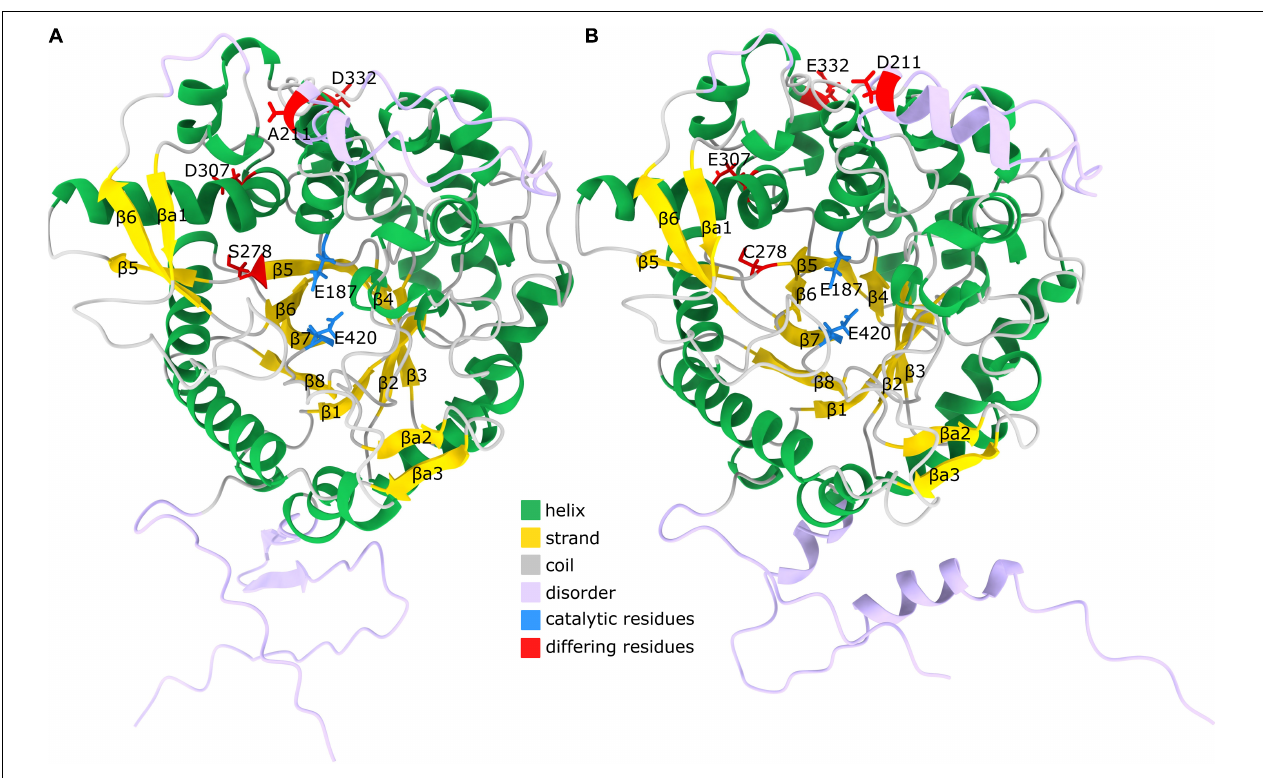
FIGURE 8 | Predicted structure of Ce BGlu. (A) AlphaFold model of Ce BGlu1. Helices are shown in green, strands in gold and coils in gray. Regions with pLDDT < 80 are indicated with lavender color. The two active site residues Glu187 and Glu420 are indicated with blue color, while residues differing between Ce BGlu1 and Ce BGlu2 are indicated in red (B) AlphaFold model of Ce BGlu2. Coloring is as under (B)